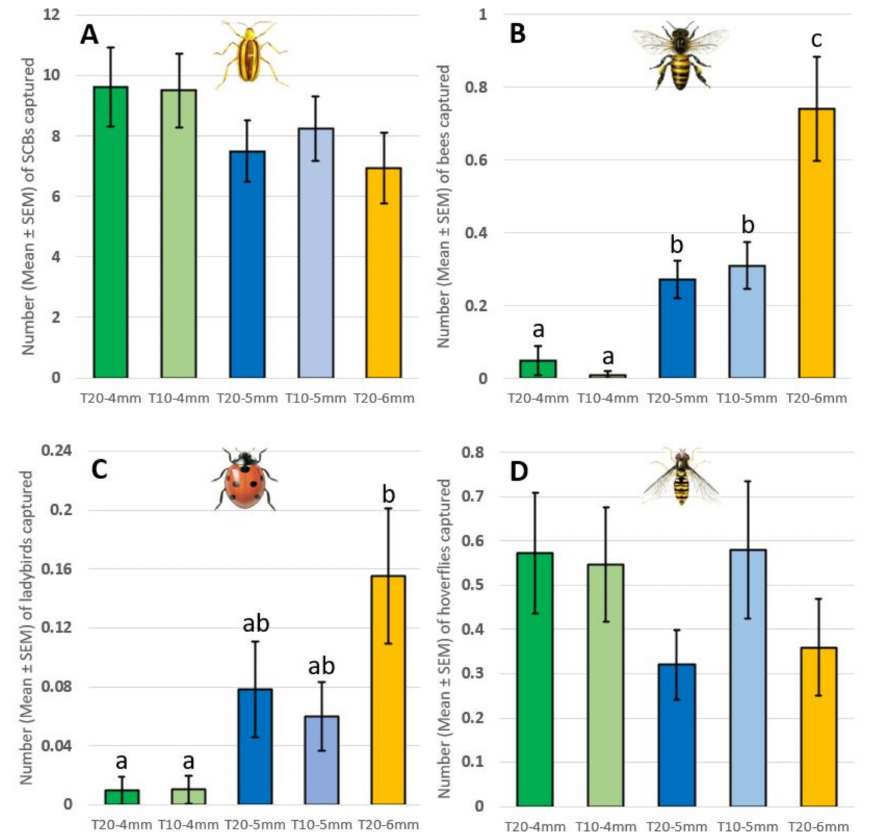
Figure 2. Number of SCBs, ladybirds, bees, and hoverflies captured in different trap types (ANOVA). ( A ) SCB—F 5,499 = 0.85, p = 0.49; ( B ) bees—F 4,503 = 13.78, p < 0.001; ( C ) ladybirds—F 4,500 = 4.31, p < 0.01; ( D ) hoverflies—F 4,501 = 0.96, p = 0.43). Different letters above bars indicate